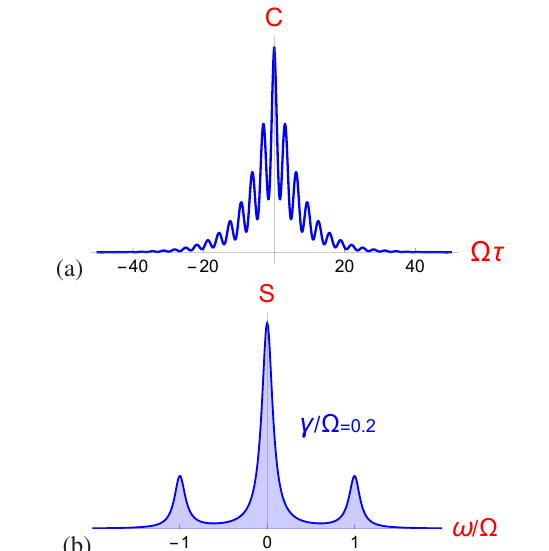
(a) Scaled correlation functions of the radiated field, without the rapid phase, c ( ⌦ ⌧ ). (b) Fourier transform of c ( ⌦ ⌧ ), or ! spectrum versus the shifted frequency ! L , for small damp- − γ/ ⌦ =